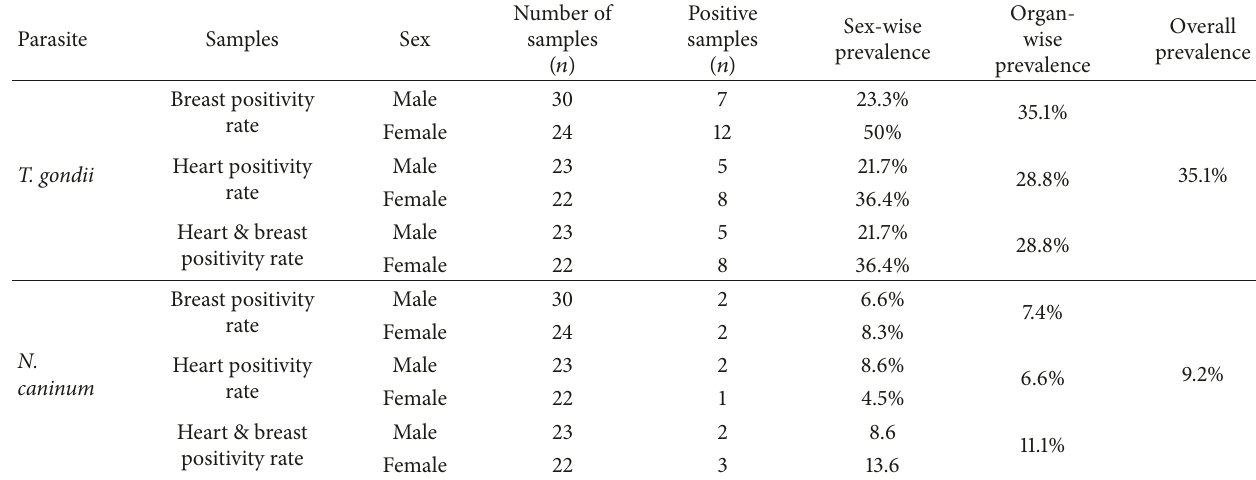
Table 1: Prevalence of apicomplexan parasites in heart and breast muscles of rock pigeons.